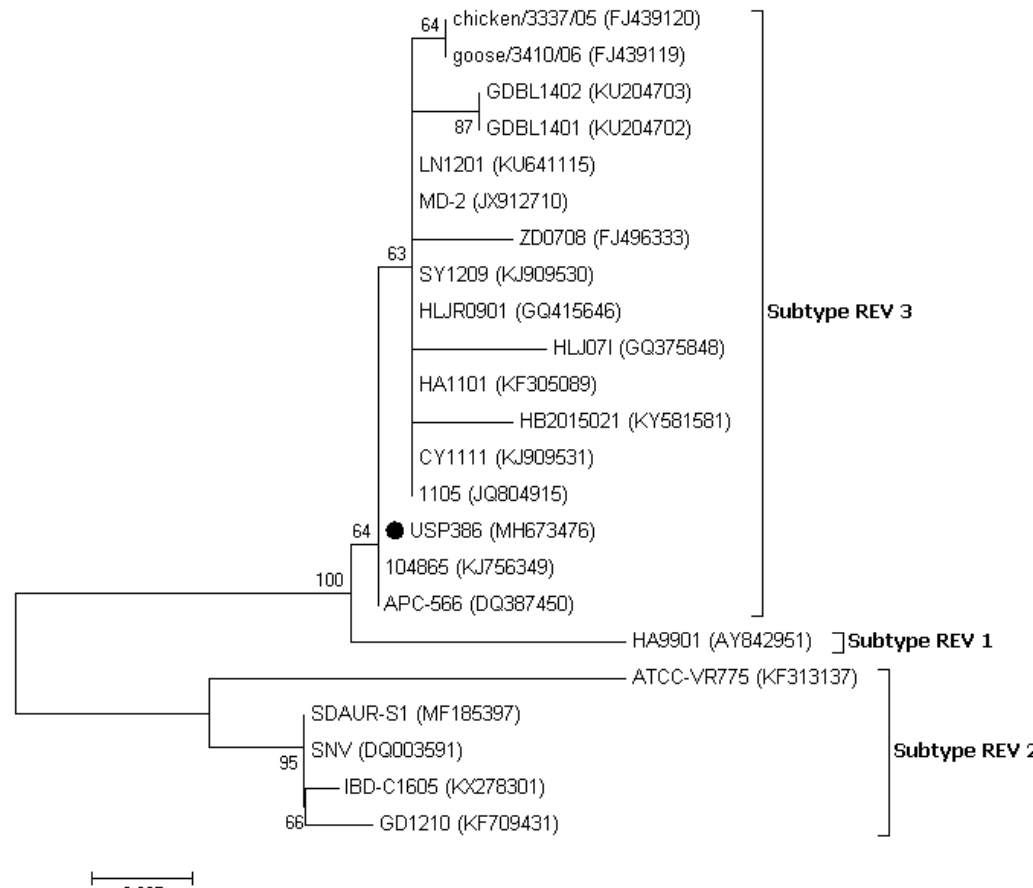
Figure 5. Phylogenetic analysis of the nucleotide sequences of the REV strains based on the partial env gene. The strain names and GenBank accession numbers are shown. The black circle represents the field REV strain used in this study. The phylogenetic tree was constructed in MEGA v7.0 using the Neighbor-Joining method with 1000 bootstrap replicates. The evolutionary distances were computed using the Kimura 2-parameter model (K2), and the scale bar represents the number of base substitutions per site.